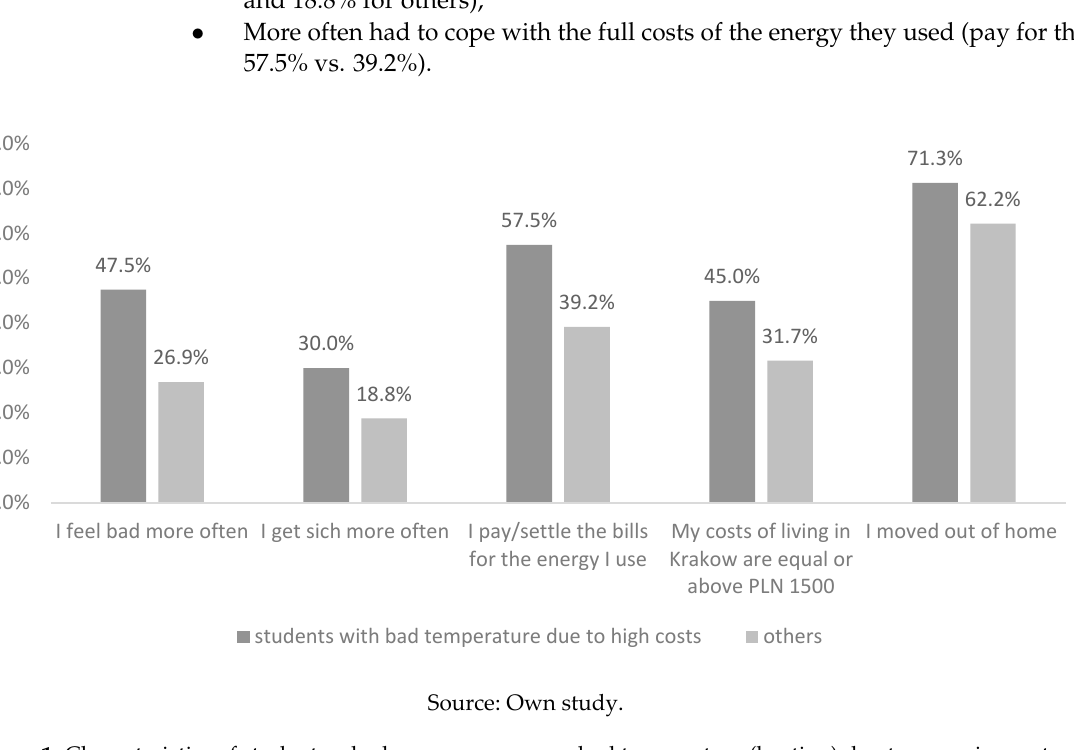
Figure 1. Characteristics of students who have concerns over bad temperature (heating) due to excessive costs.